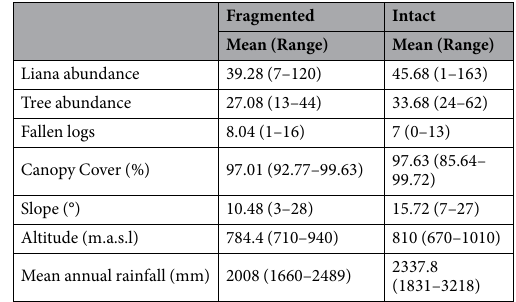
Table 1. Mean and range of the environmental and ecological traits assessed to determine their influence on rattan abundance in the fragmented and intact forests of the Atherton Tablelands, northeastern